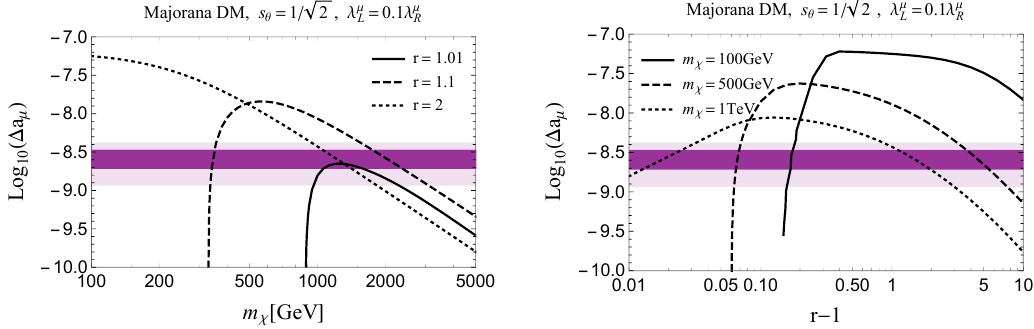
Figure 11 . The same plots for the Majorana DM as (cid:12)gure